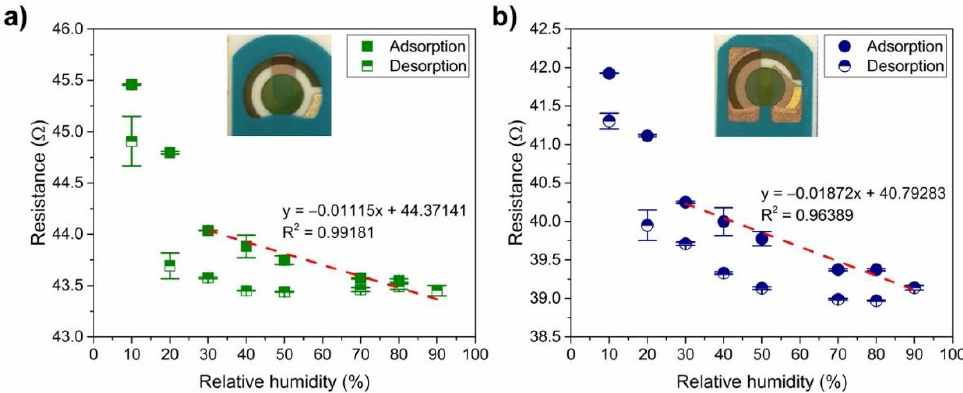
Figure 7. Reversibility of the PANI-Au-SPE sensor after exposing to increasing relative humidity (RH): ( a ) connection 1 and ( b ) connection 2. Both figures, ( a , b ), contain linear fitting for the adsorption of water between 30% and 90%